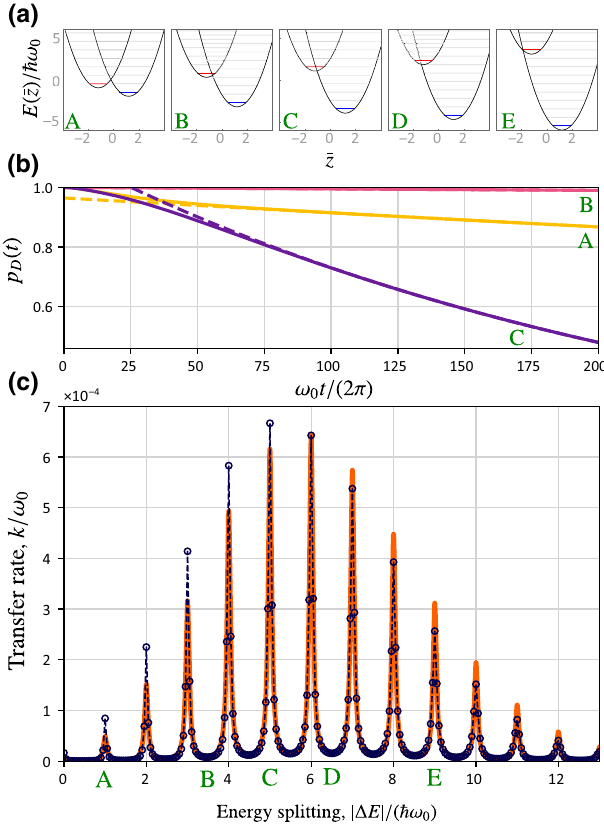
FIG. 3. Quantum nonadiabatic (QN) transfer. (a) Diabatic BO energy surfaces and their vibrational levels for the quantum nonadiabatic transfer regime. The system parameters are set to V = 0.01 (cid:2) ω 0 , g = 2.5 ω 0 , γ = 0.05 ω 0 / 2 π , and ¯ n = 0.01. Con- sequently, the initial thermal population beyond the ground state amounts to less than 1%, corresponding to k B T ≈ 0.217 (cid:2) ω 0 and we further have λ = 6.25 (cid:2) ω 0 . The panels show | (cid:2) E | = (cid:2) ω 0 (A), | (cid:2) E | = 5 (cid:2) ω | (cid:2) E | = 6.5 (cid:2) ω | (cid:2) E | = 3.5 (cid:2) ω 0 (B), 0 (C), 0 (D), and | (cid:2) E | = 9 (cid:2) ω 0 (E). (b) The dynamical evolution of the donor pop- ulation (continuous lines), with exponential fits (dashed lines), for the parameters of panels A (yellow), B (pink), and C (vio- let). (c) The transfer rates (dark blue circles) are extracted from the exponential fits in (b). The orange line displays the